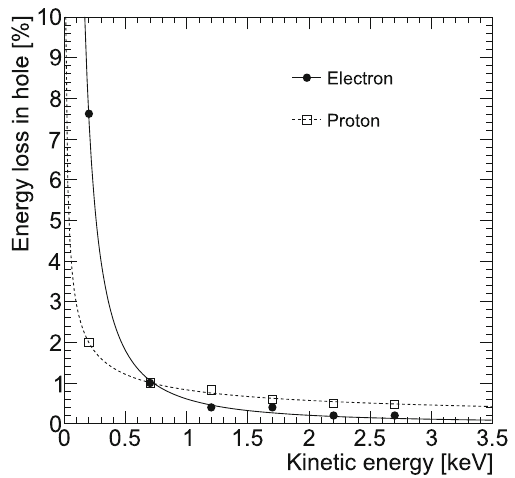
Fig. 4 SimulationoftheenergylossintheComimac’sholeofdiameter 1 . 45 µ m for 100 mbar of CH 4 . The fit functions are